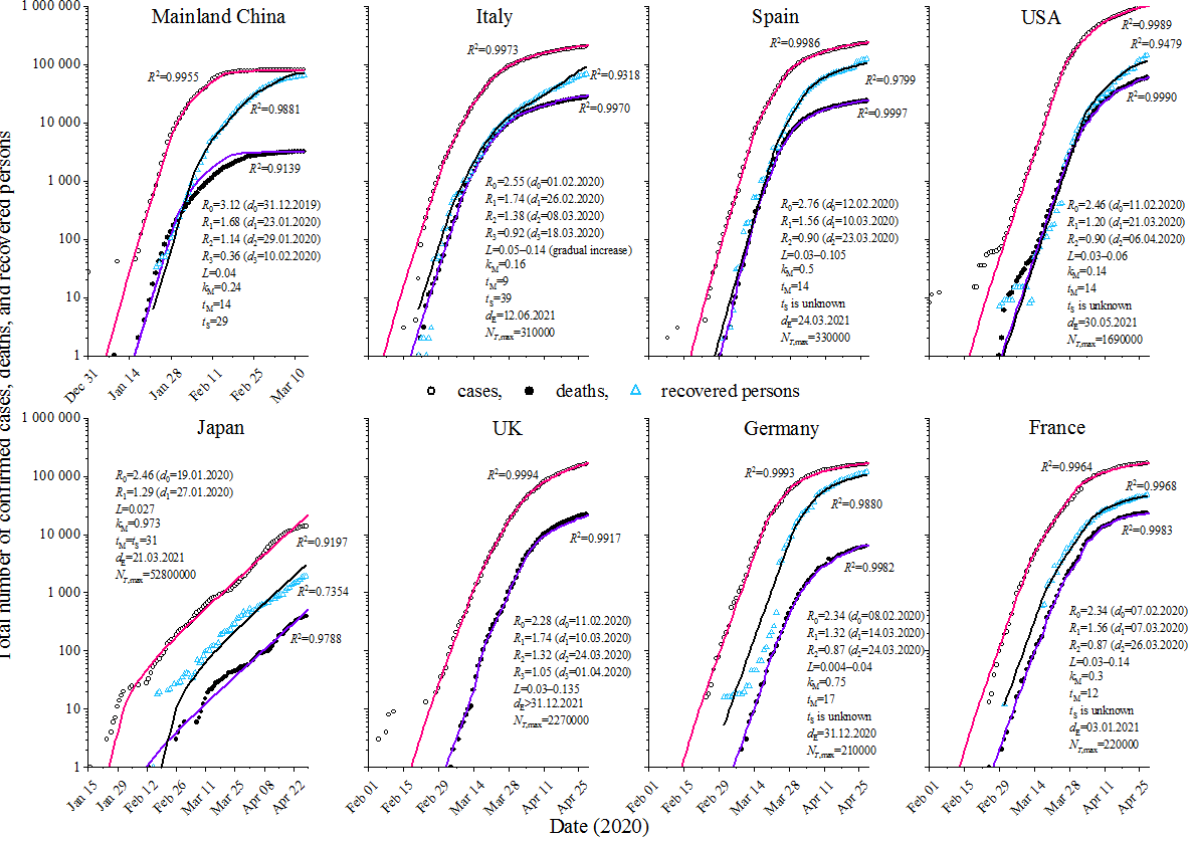
Figure 1. Time dependences of the total number of COVID-19 cases, deaths, and recovered cases. Dots show actual data, whereas lines represent the result of calculations using the model.